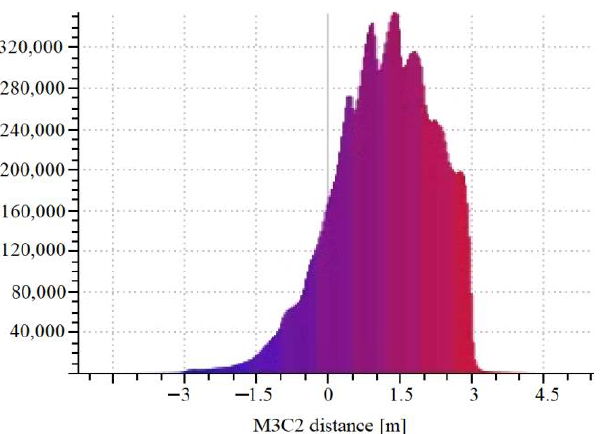
Figure 13. Histogram of the Model-to-Model Cloud Comparison (M3C2) distance. Negative values are errors from the computation occur on the borders only, caused by missing marginal data in both files. These data were filtered out.